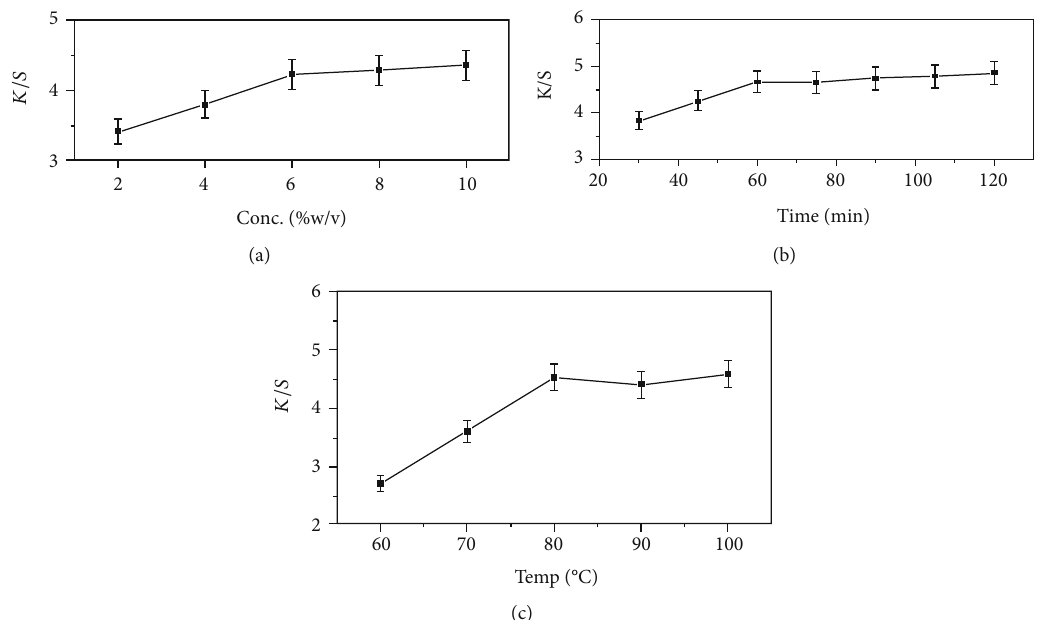
Figure 2: K / S values against dyeing condition, (a) dye concentration (% w / v ), (b) time (min), and (c) temperature ( ° C). Table 1: Color values of fabrics after dyeing at temperature 80 ° C for 60 min at a dye concentration of 6% w / v and liquor ratio of 1 :30,